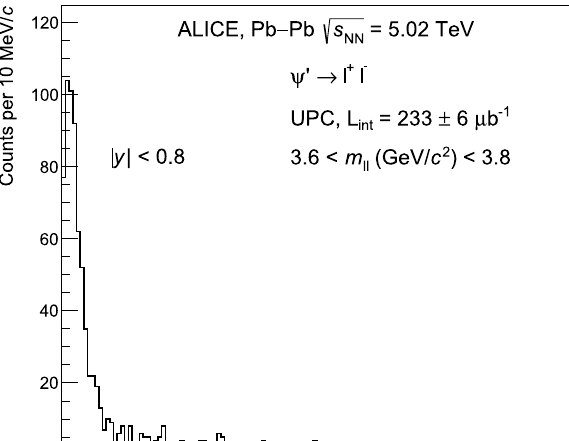
background and signal functions. Right: Transverse momentum distri- bution of ψ (cid:2) candidates in the mass range quoted in the figure (around the ψ (cid:2)